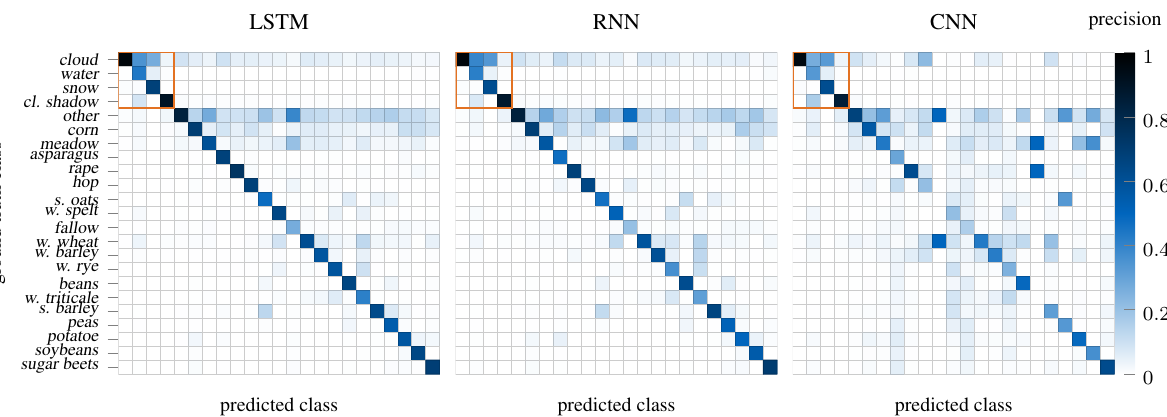
Figure 9. Confusion matrices reporting class-wise average accuracy values of LSTM, RNN, and CNN architectures. The orange-framed submatrix comprises covered classes. While LSTM and RNN showed similarily good performances, as these networks utilize temporal features, the CNN network performed generally worse, as temporal characteristic features are not accessible to the CNN architecture.